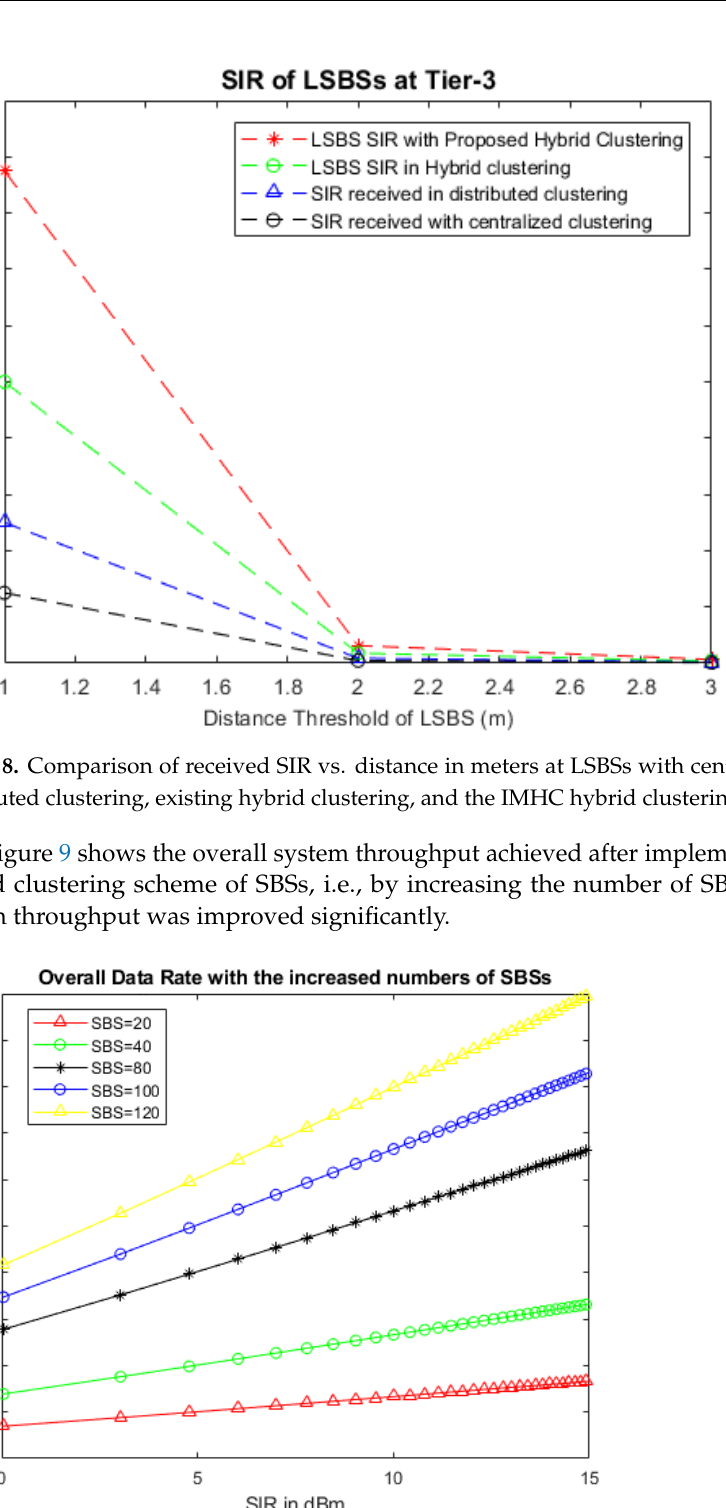
Figure 7. Comparison of received SIR vs. distance in meters at LSBSs with centralized clustering, distributed clustering, existing hybrid clustering, and the IMHC hybrid clustering scheme.